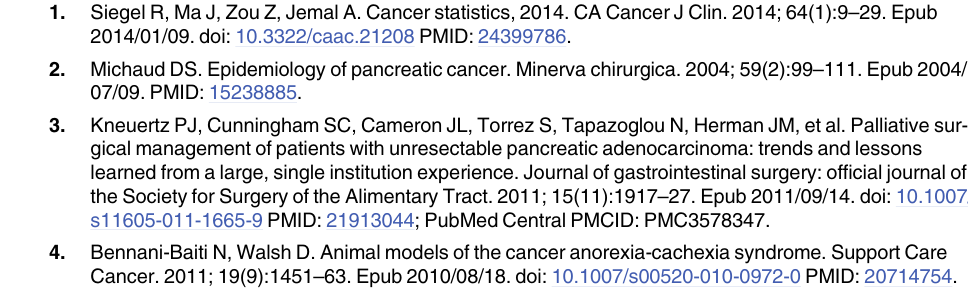
S1 Fig. TLR9 deletion does not protect against pancreatic cancer cachexia. (A) WT and were treated TLR9 -/- mice were treated with PBS or Pan02 and tested for overall weight change, and changes in (B) lean body mass, (C) fat mass, (D) bone mineral density, (E bone mineral content, and (F) arm circumference (n = 10/group). S2 Fig. TGF- β expression in pancreatic carcinoma tissues (A) Expression of TGF- β was tested by immunohistochemistry in Pan02 peritoneal carcinomatosis and (B) in the pancreata of KPC mice. (C) Expression of p21 was tested by immunohistochemistry in Pan02 peritoneal carcinomatosis and (D) in the pancreata of KPC mice. (E) Expression of p-Smad2/3 was tested by immunohistochemistry in Pan02 peritoneal carcinomatosis and (F) in the pancreata of KPC mice. (G) Protein levels of p21 in quadriceps muscle of mice treated with PBS and Pan02 were tested by Western blotting (n = 5/group). S3 Fig. Effects of TGF- β inhibition on control mice. (A) Mice were treated with PBS or 11D1.16.8 and tested for weight change, and changes in (B) lean mass, (C) fat mass, (D ) arm circumference, or (E) bone mineral density (n = 10/group). S4 Fig. TGF- β inhibition improves overall survival and body composition in a second model of pancreatic cancer cachexia. (A) Mice were treated with FC1242 or FC1242 + 11D1.16.8 and tested for survival using Kaplan-Meier analysis. (B) Cohorts of mice were also tested for change in fat mass, (C) change in bone mineral density, and (D) body fat percentage (n = 5/group; (cid:1) p < 0.05). S5 Fig. Effect of TGF- β inhibition on neurocognitive function. (A) Mice were treated with PBS, Pan02, or Pan02+11D1.16.8 and tested for rotarod running speed, or (B) object recogni- tion (n = 5/group; (cid:1) p <